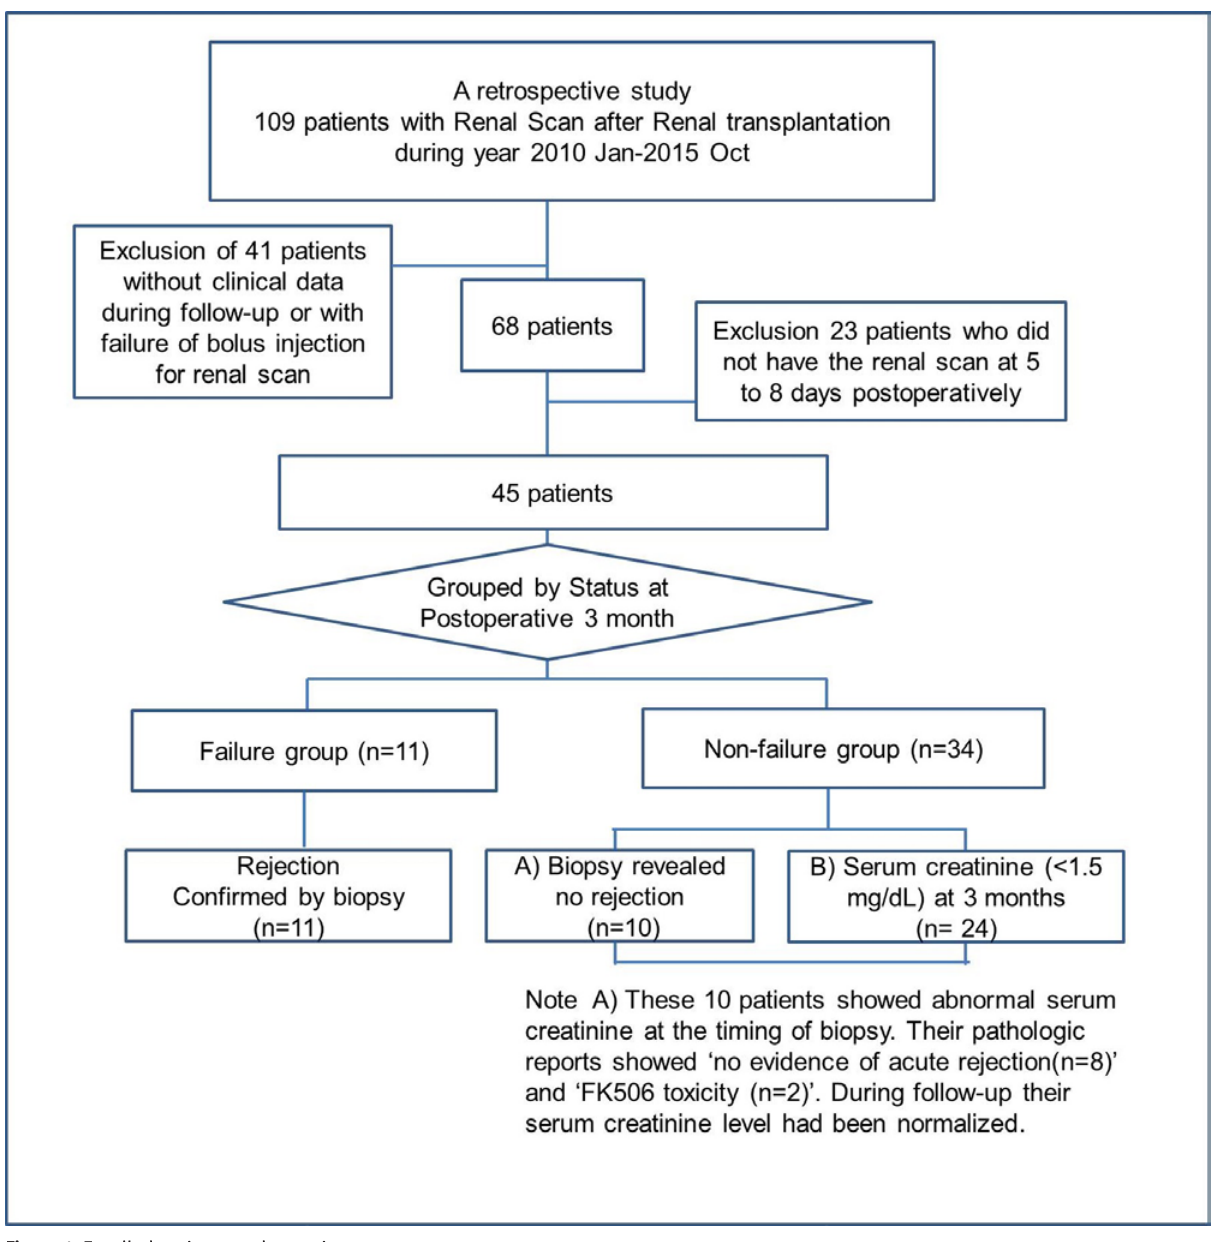
Figure 1: Enrolled patients and